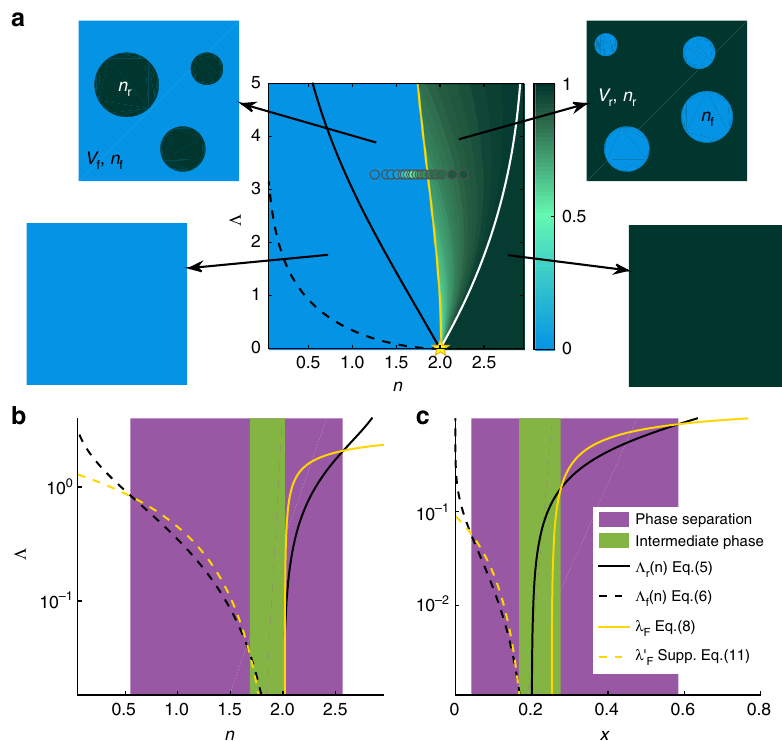
Fig. 4 Phase diagrams of network structures near the rigidity threshold. a Phase diagram of the model in n - Λ space. The star sign marks the critical point at n = d , Λ = 0. The phase boundaries shown by black and white solid lines de fi ned in Eqs. (5), (6) and (7) separate the heterogeneous phase mixed of c c fl oppy and stressed regions and homogeneous phases as illustrated. The fl oppy parts are in light blue and the stressed parts are in dark green. The dashed line shows the phase boundary Eq. (10) towards a fl oppy-isostatic mixture phase. The color bar labels the probability of a bond in the percolating cluster P n * ( Λ ) when the rigid phase reaches half volume fraction. Numerical data of N = 576 λ = 3.3 are shown in circles. b Phase ∞ , which jumps at the yellow line diagram of model at T g with Λ in log scale. The black solid and dashed line reproduce the phase boundaries (white solid and black dashed) in a . On the rigid side n > n c , when the free energy loss at T g given by Eq. (11) shown by yellow solid line is above the boundary, the heterogeneous networks appear in equilibrium. When n < n c , the phase separation is stable when the yellow dashed line showing the free energy loss given by Supplementary Eq. (19) goes beyond the heterogeneous boundary. c Same phase diagram showing the intermediate phase for compounds A x B 1 − x . The purple regions show the range of heterogeneous phases, and the green region is the homogeneous intermediate